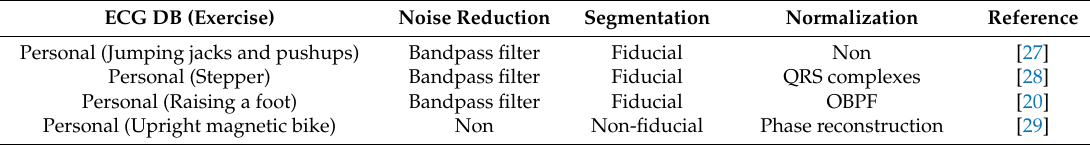
Table 2. Preprocessing in the post-exercise state for